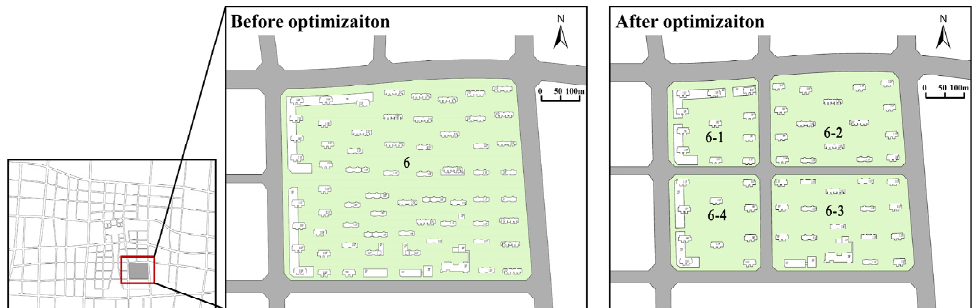
Figure 9. Comparison of residential land 6 before optimization and residential lands 6-1, 6-2, 6-3, and 6-4 after optimization.